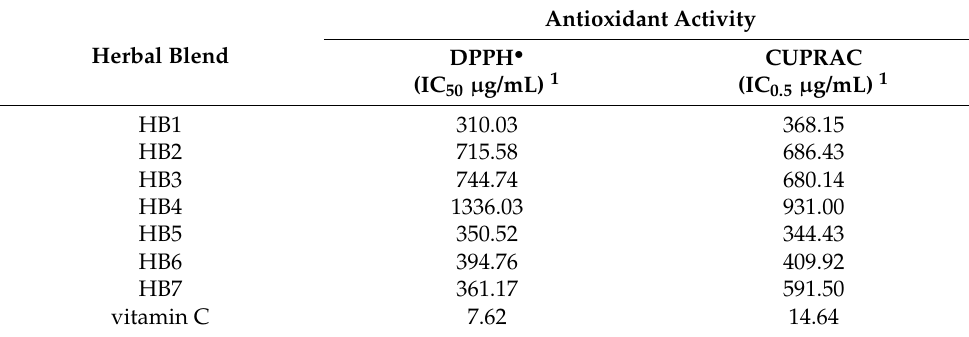
Table 6. Antioxidant activity of tested herbal